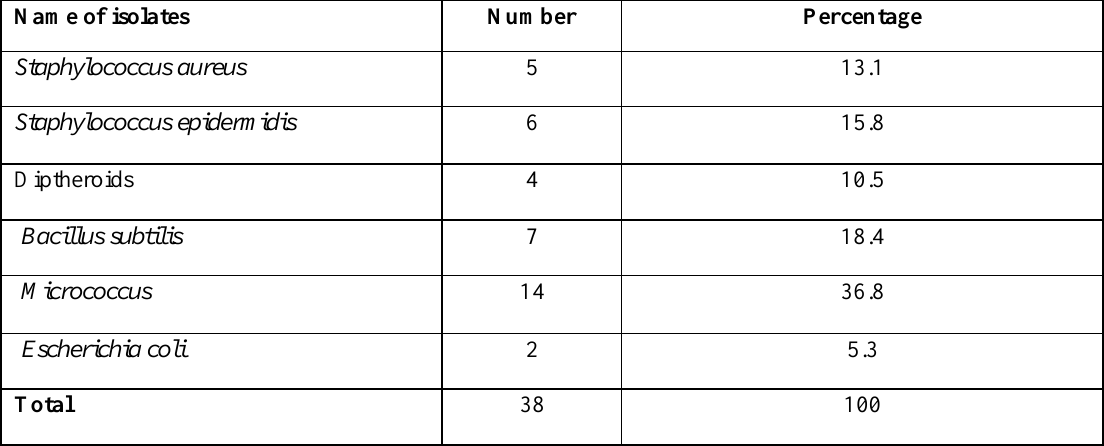
Table 2. Percentage of bacterial isolates from various samples. Name of